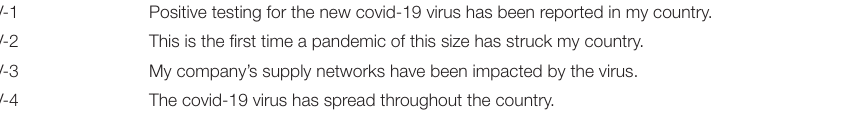
TABLE 2 | Determine the COVID-19 of evaluation points.